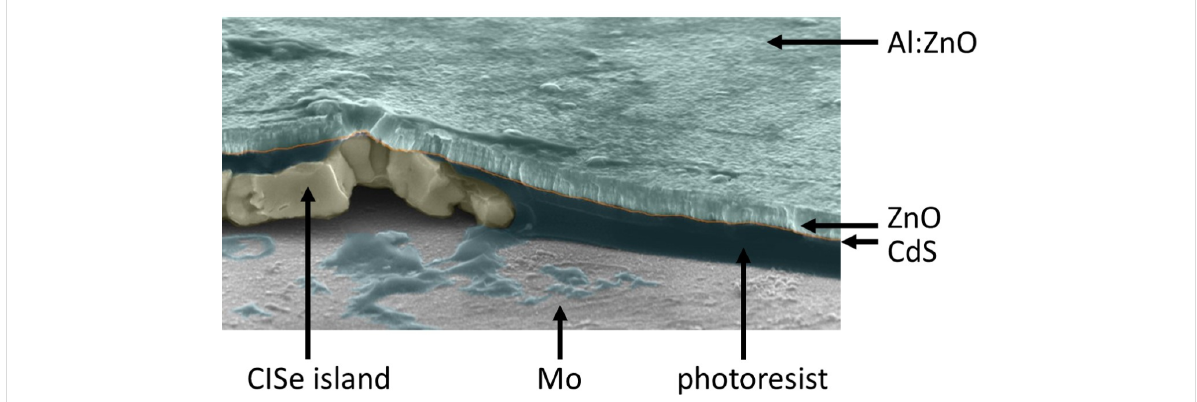
Figure 13: Cross section of a CISe micro absorber island after processing to a micro cell imaged by tilted-view SEM. Note that the different materials were artificially post-colorized to enhance their visibility. The height of the CISe absorber is ca.1 µm.